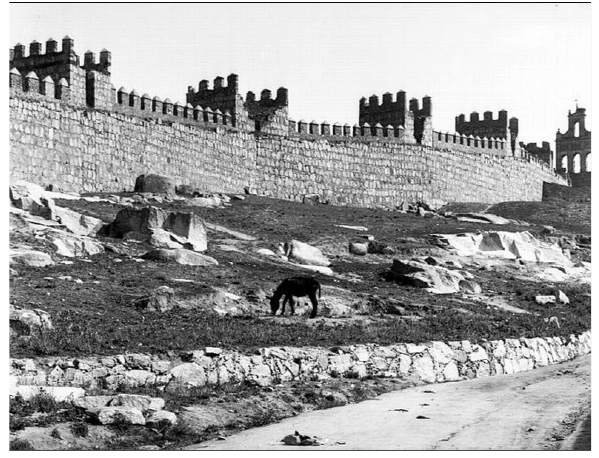
Figure 1. Avila. North canvas of the walls. Interior side. Photo: Eugene Lefèvre- pontaiis. h. 1930. Col Ministry of Culture. France. European Archive. (NUMP)